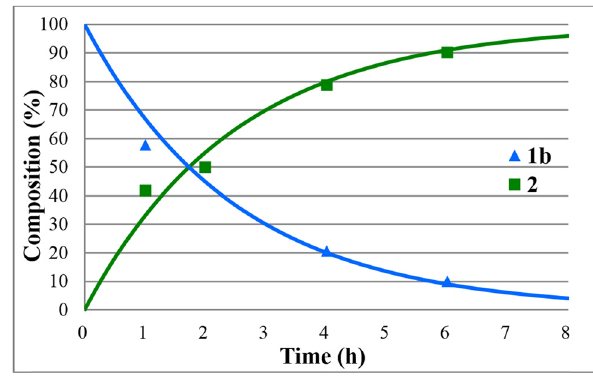
Figure 10: Concentration pro fi le for the components ( 1b and 2 ) during the alkaline hydrolysis of ethyl diphenylphosphinate ( 1b ) at 50°C, in the presence of 1.2 equiv. NaOH. The R 2 measure of good - ness of fi t is 0.931.